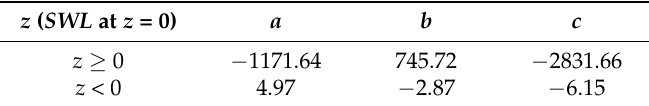
Table 3. Coefficients a , b, and c for Equation (6).